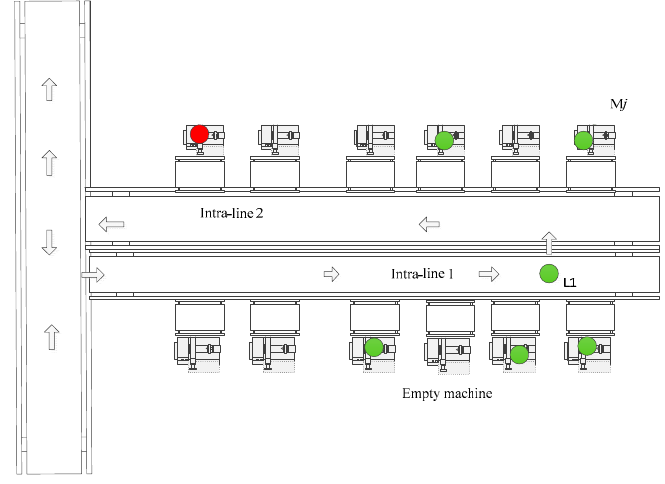
Figure 11. Skip occupied machine.